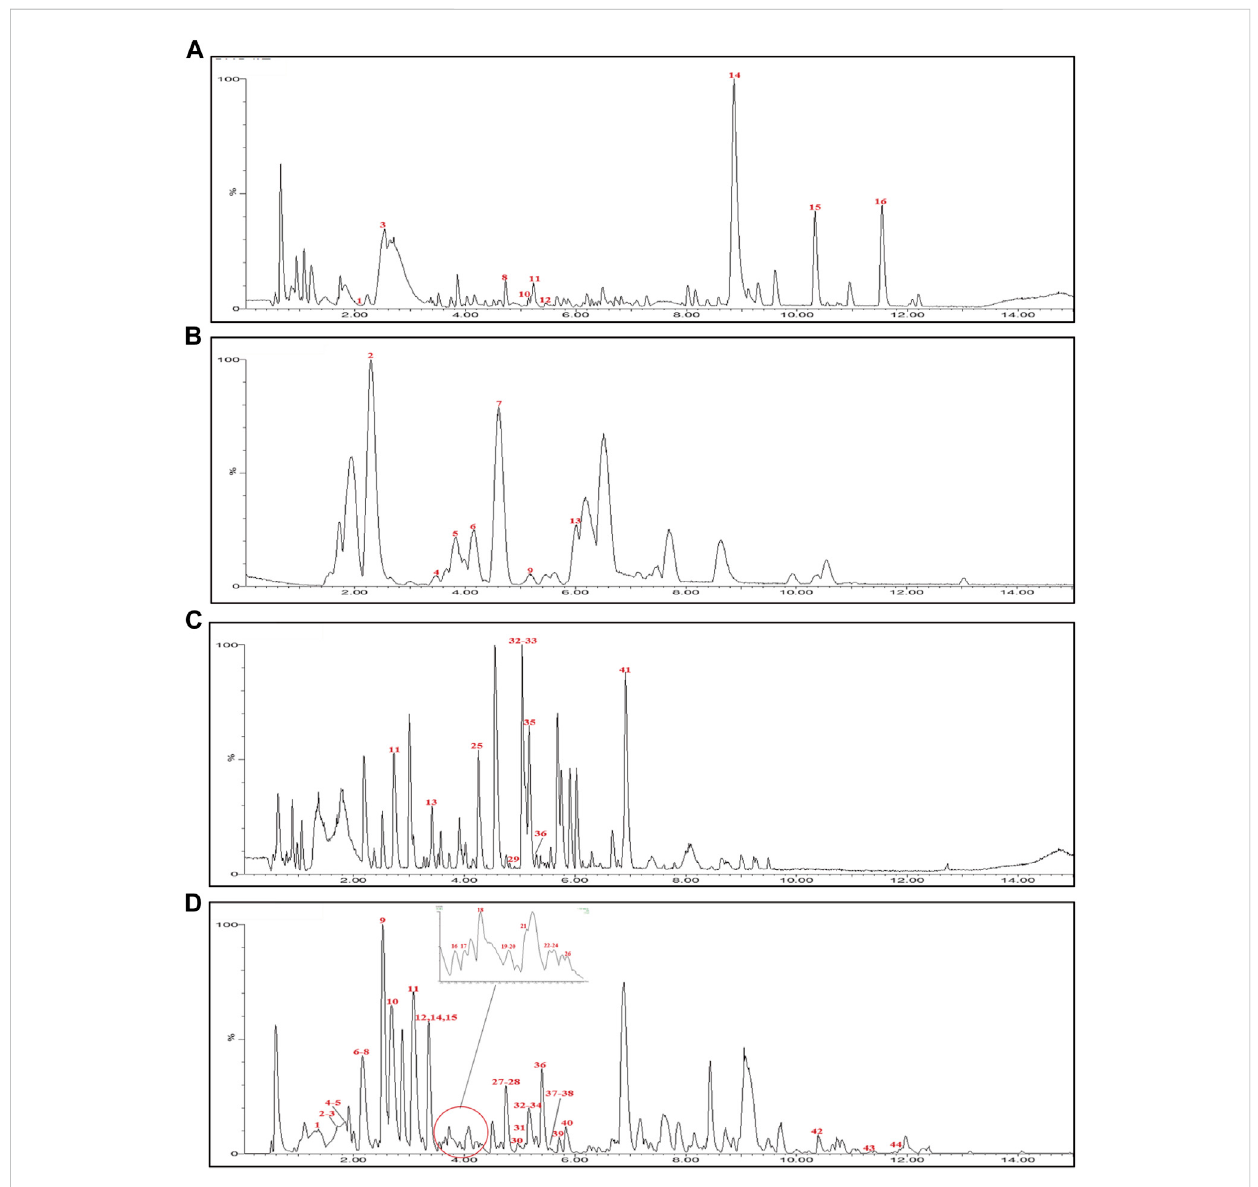
FIGURE 2 Base peak intensity (BPI) chromatograms for Alangium chinense extract (AC) and extract of compatible herbs of Jin-Gu-Lian formula (CH) by ultra- performance liquid chromatography-quadrupole-time-of- fl ight tandem mass (UPLC-Q-TOF-MS). (A) BPI chromatogram of the positive (ESI+) ionization modes for AC; (B) BPI chromatogram of the negative (ESI − ) ionization modes for AC; (C) BPI chromatogram of the positive (ESI+) ionization modes for CH; (D) BPI chromatogram of the negative (ESI − ) ionization modes for